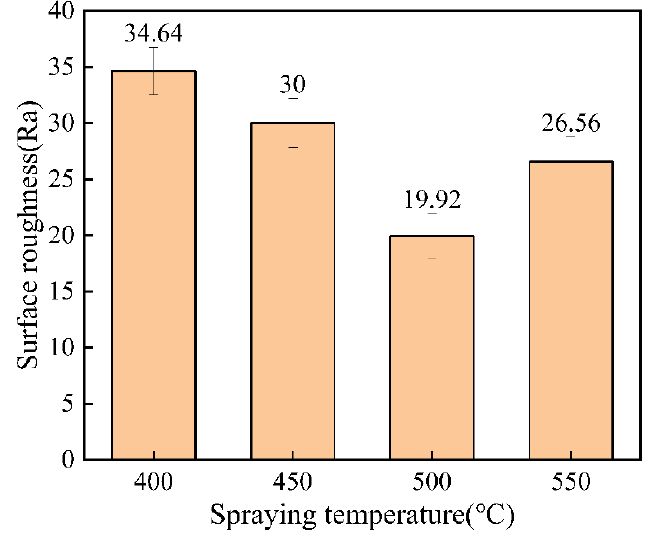
Figure 7. Surface roughness of coating at different spraying temperatures.